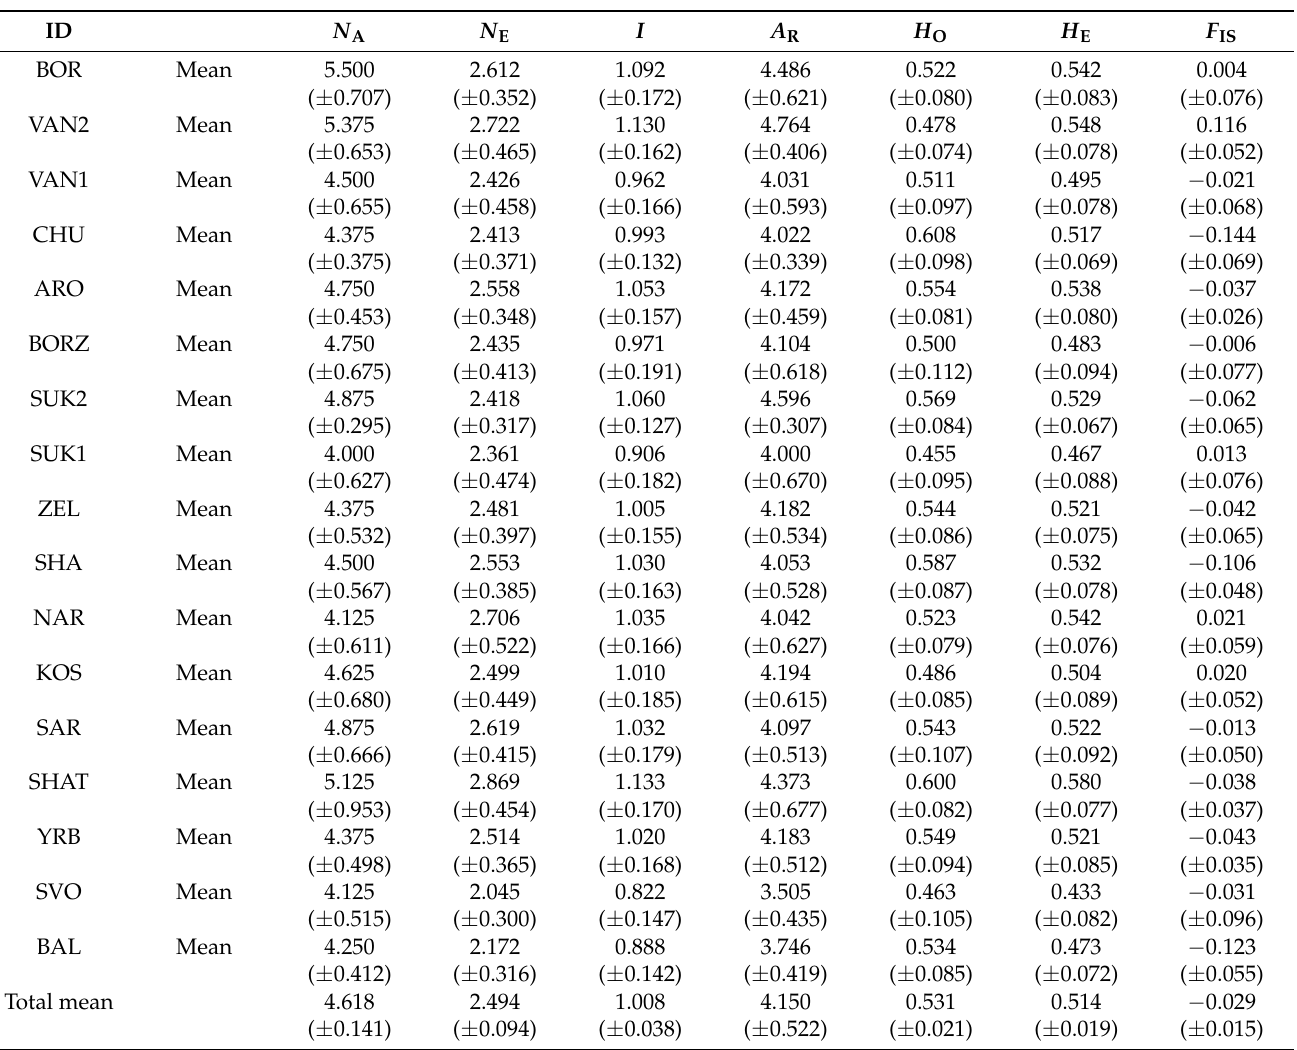
Table 3. Genetic diversity indices averaged across eight microsatellite loci for each Scots pine population.